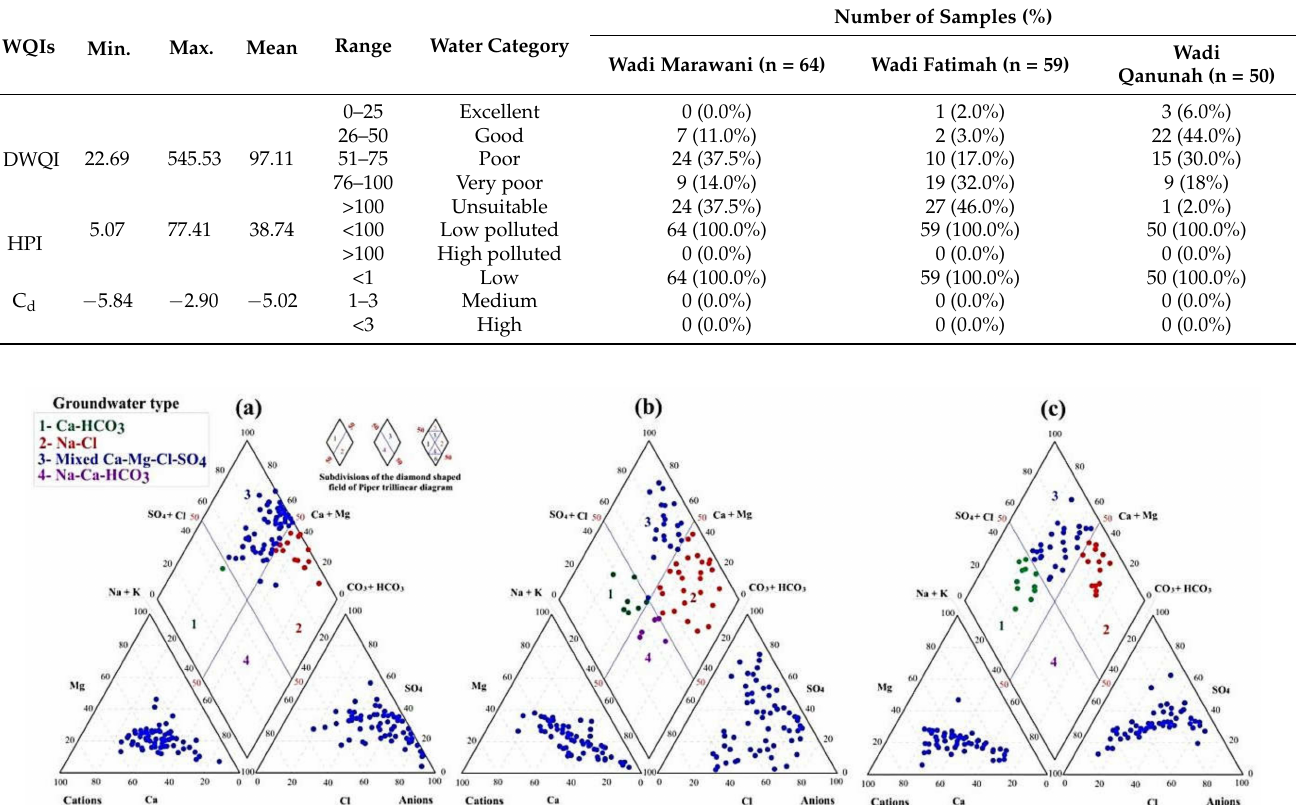
Figure 6. Geochemical facies and water type for selected wadies: ( a ) Wadi Marawani, ( b ) Wadi Fatimah, and ( c ) Wadi Qanunah, Makkah Al-Mukarramah Province.